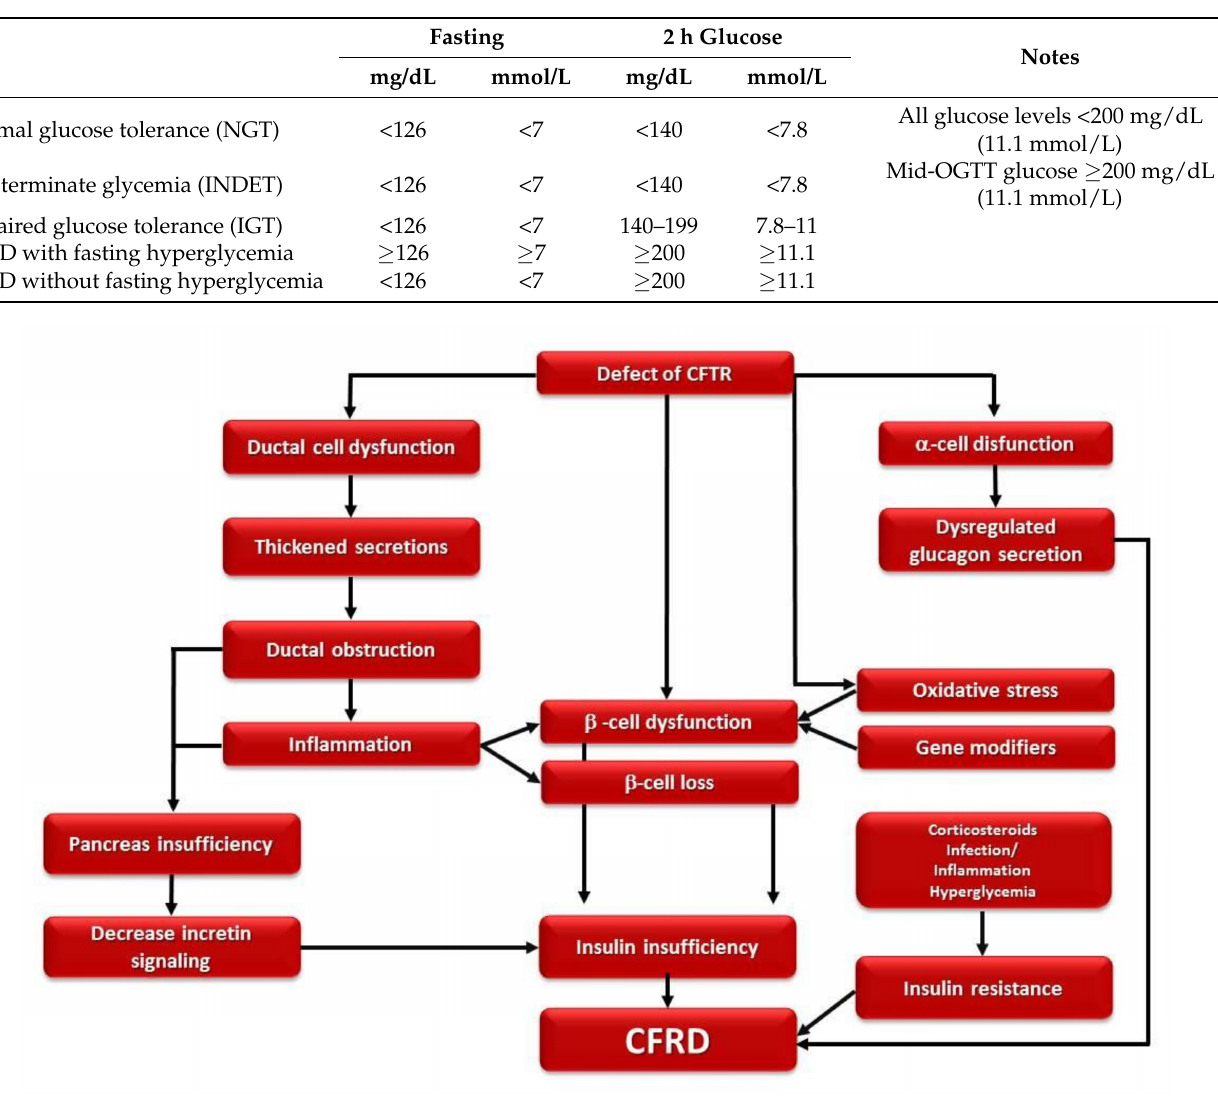
Table 2. Interpretation of oral glucose tolerance test (OGTT) in cystic fibrosis.